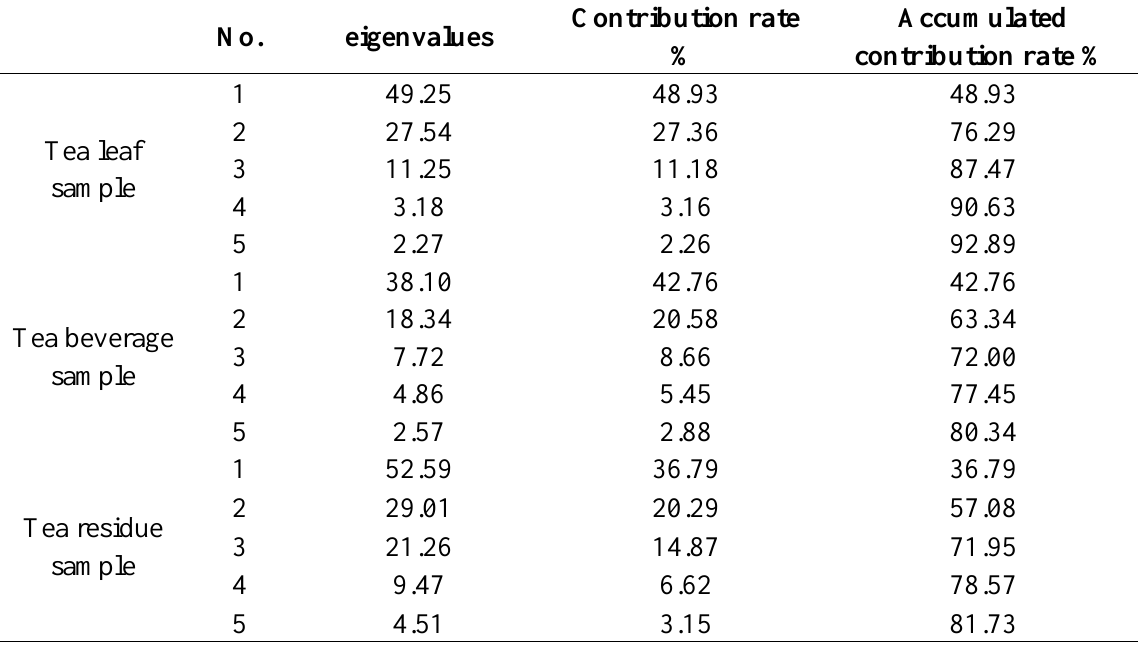
Table 1. The eigenvalues and the accumulated contribution rate of the front five principal components of tea leaves, tea beverages and tea residues under different storage